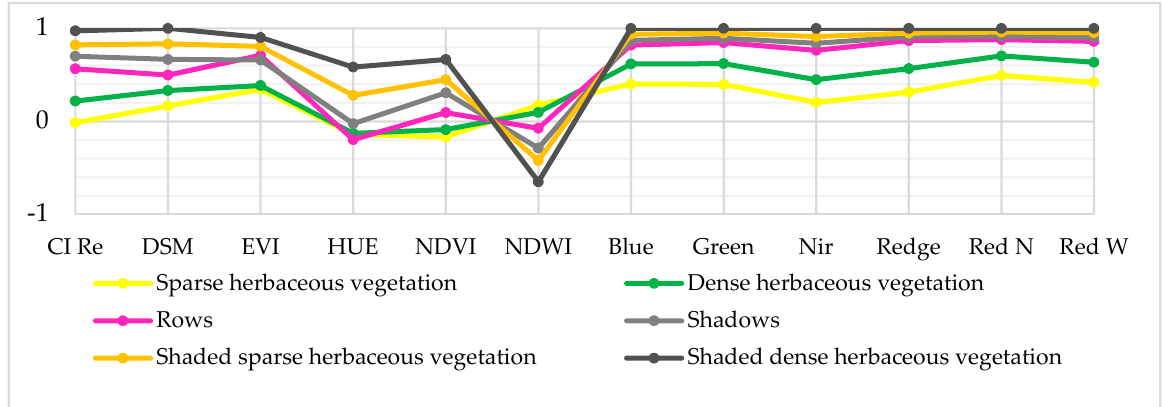
Figure 5. Spectral signatures of the classes. The values were scaled on a − 1—1 range to facilitate the reading of the graph. The first level classification (Classification I) was performed using the Minimum Distance algorithm, with a threshold (standard deviation from the mean) of 2-sigma for classes Rows , Shaded Sparse Herbaceous Vegetation, Shaded Dense Herbaceous Vegetation , and Sparse Herbaceous Vegetation and 3-sigma for Shadows and Dense Herbaceous Vegetation . The result was then postprocessed applying a 15-pixel sieving filter and 4-pixel dilation on the Rows class. The areas classified as Shadows were masked and used for the second classification (Classification II). It was realised with the same algorithm and settings of Classification I. The main accuracy measures based on the error matrix (Producer’s